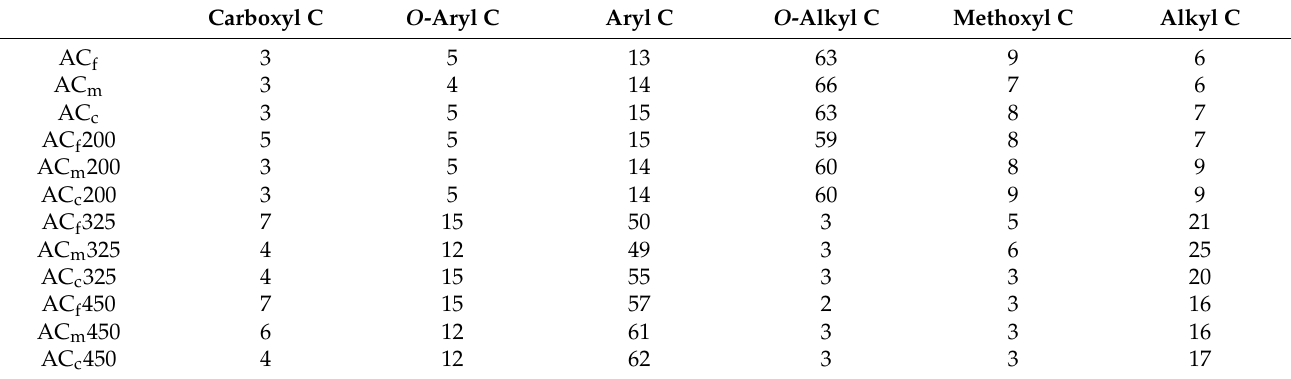
Table 3. Intensity distribution (%) in the 13 C NMR spectra of the endocarp of Acrocomia at different particle sizes (f: fine; m: middle; c: coarse) and its biochars produced at 200 ◦ C (AC200), 325 ◦ C (AC325) and 450 ◦ C